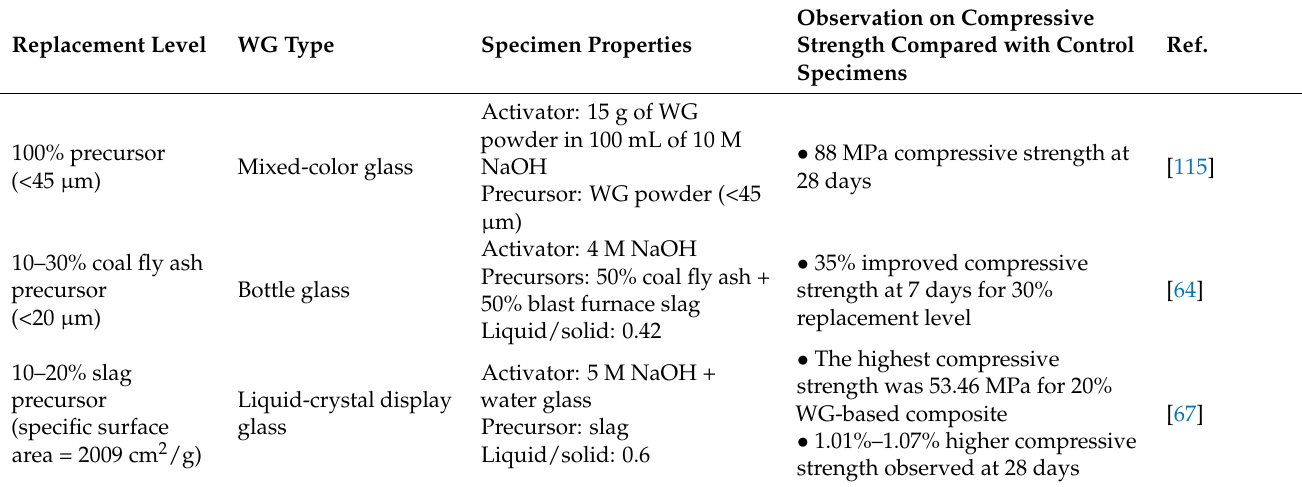
Table 6. Observation of the strength of WG-based geopolymer